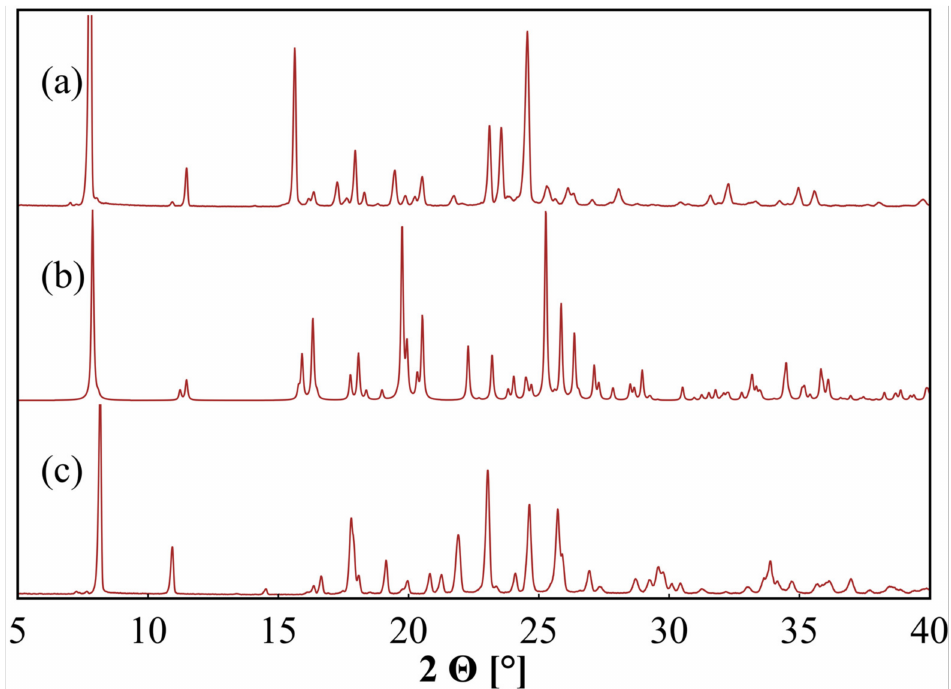
Figure 5. Powder patterns of ( rac )-3 based maleates. Sample of ( rac )-3-MA obtained by solution crystallization, a larger amount of form I ( a ), the simulated pattern of ( rac )-3-MA-I based on single crystal data ( b ), and a sample of ( rac )-3-MA obtained by mechanochemical crystal synthesis, a larger amount of form II ( c ). Powder patterns were recorded in a range of 5 ◦ –40 ◦ 2 Θ